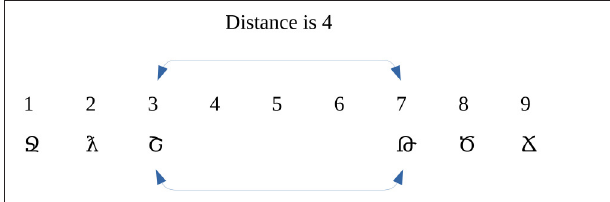
FIGURE 1 | An example of the symbols and their meanings in the present study. Arrows show the predicted distance effect size based on the predictions of the two explanations.